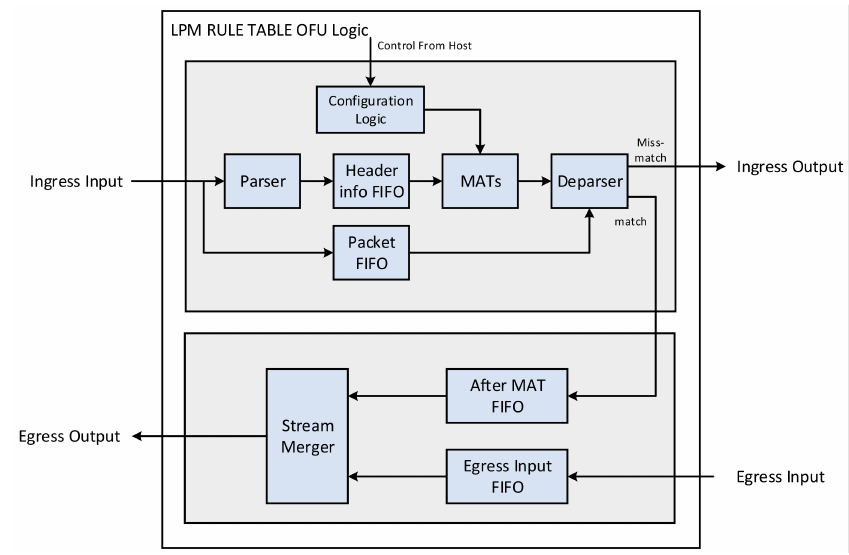
Figure 9. Logic design of the LPM-based rule table OFU.